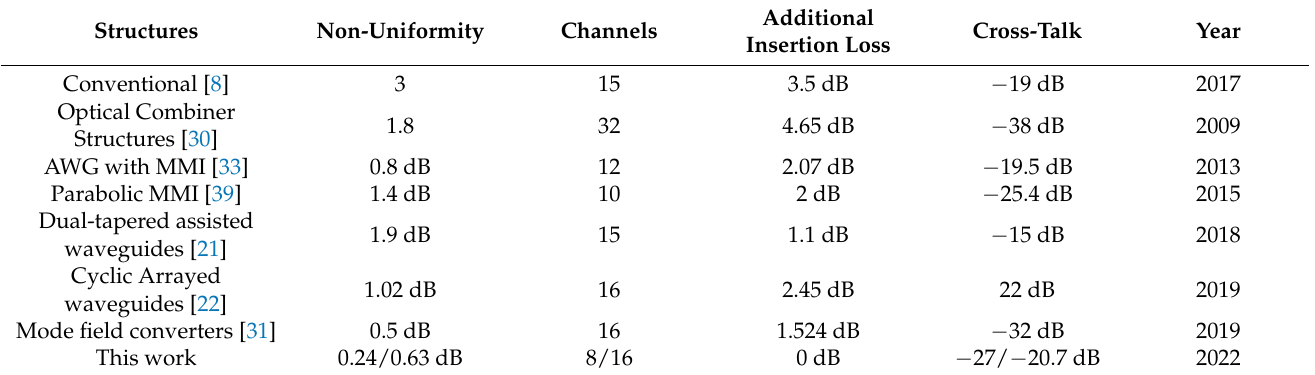
Table 2. Comparison of different high uniformity AWGs reported